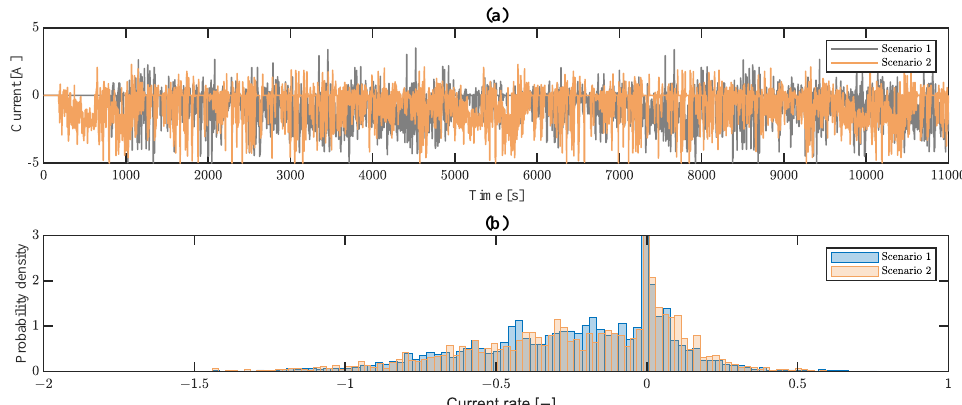
Figure 2. Dynamic load profile used for the validation of parameter estimation. ( a ) current profile; ( b ) distribution of the current